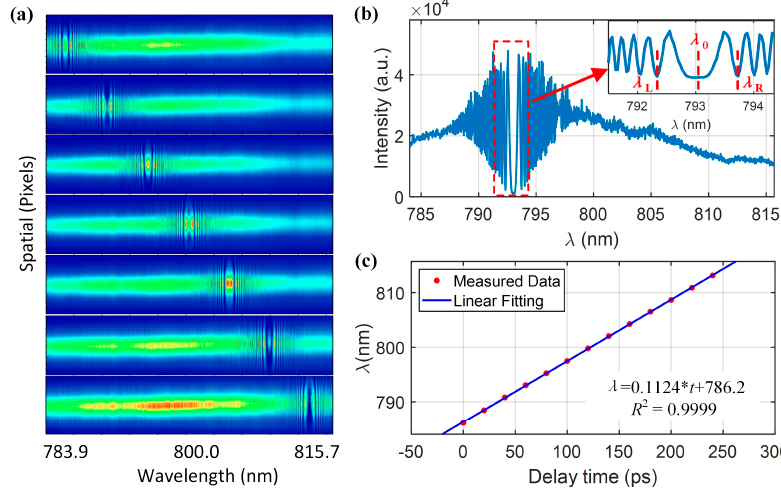
Figure 8. The measurement result of the temporal chirp of the stretched pulse. ( a ) The spectral interferograms between the fs pulse and the stretched ps chirped pulse with different delay times. The interferograms have been compressed in the spatial dimension to list more interferograms. ( b ) The interference fringe corresponding to a line of pixels in an interferogram; ( c ) the measurement data and the linear fitting between the wavelength and the delay time.